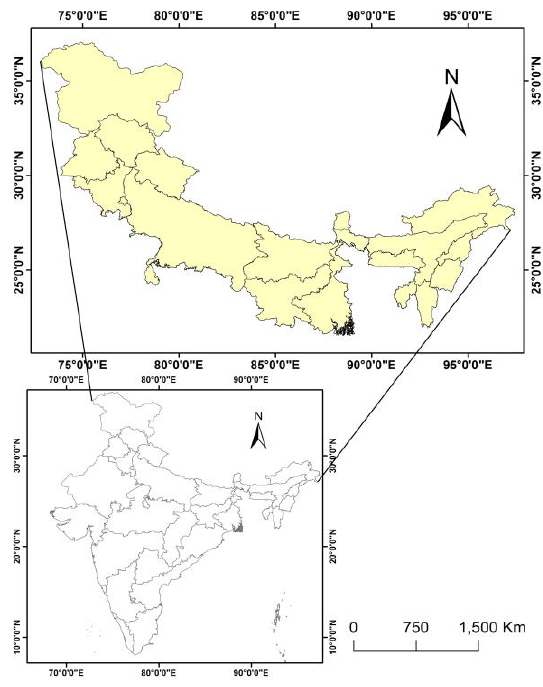
Figure 1. Study Area – Indo Gangetic Plain of